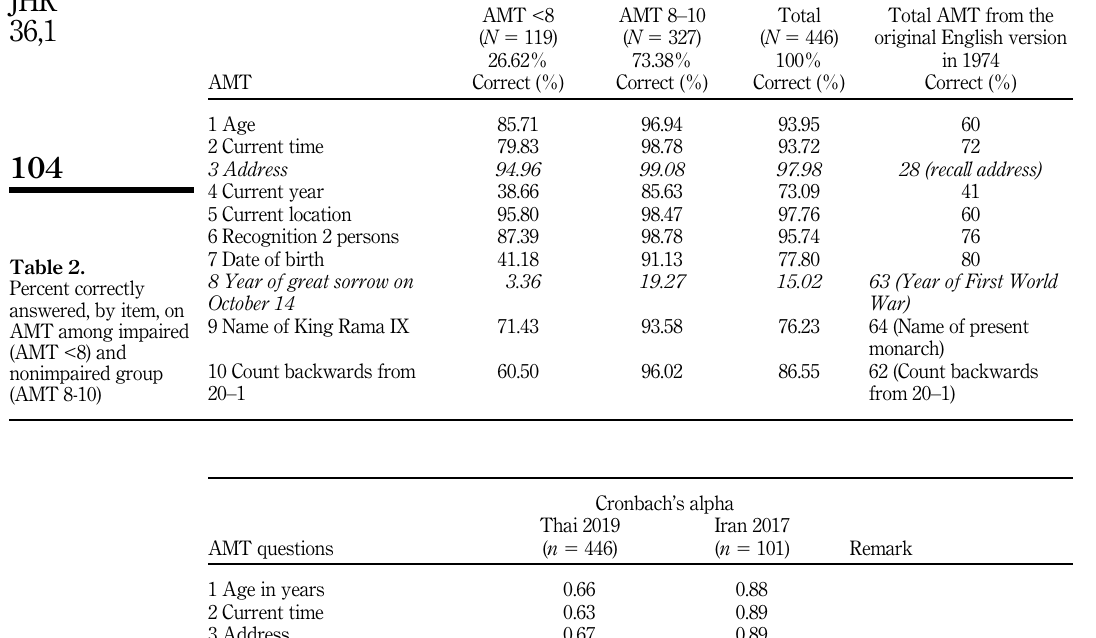
Table 3. The corrected item item-total correlations of Cronbach ’ s alpha